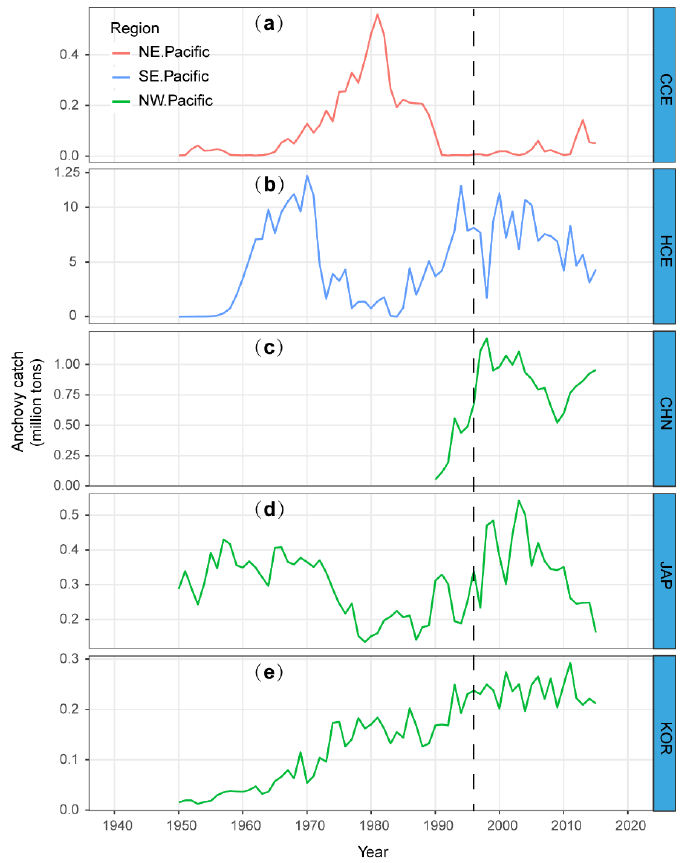
Figure 4. Long-term changes in anchovy catch in the Pan-Pacific. ( a – e ) Anchovy catch in the CCE, HCE, CHN, JAP, and KOR, respectively. CCE: California Current Ecosystem; HCE: Humboldt Current Ecosystem; CHN: China; JAP: Japan; KOR: Korea. The vertical dashed line indicates the boundary values of the [8,23], respectively.